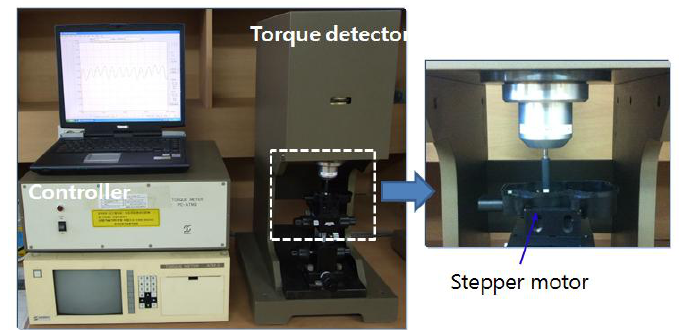
Figure 10. Experimental setup for the cogging-torque